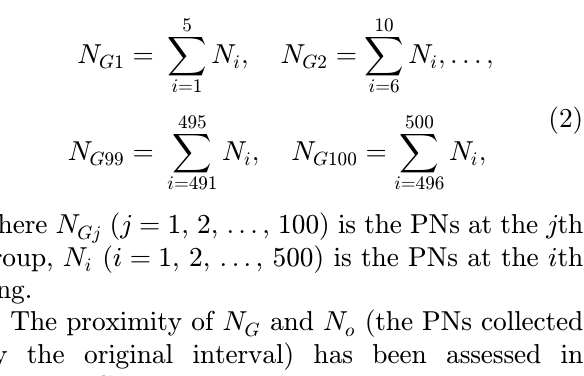
Table 2. Assessment* of the proximity of N G and N o .